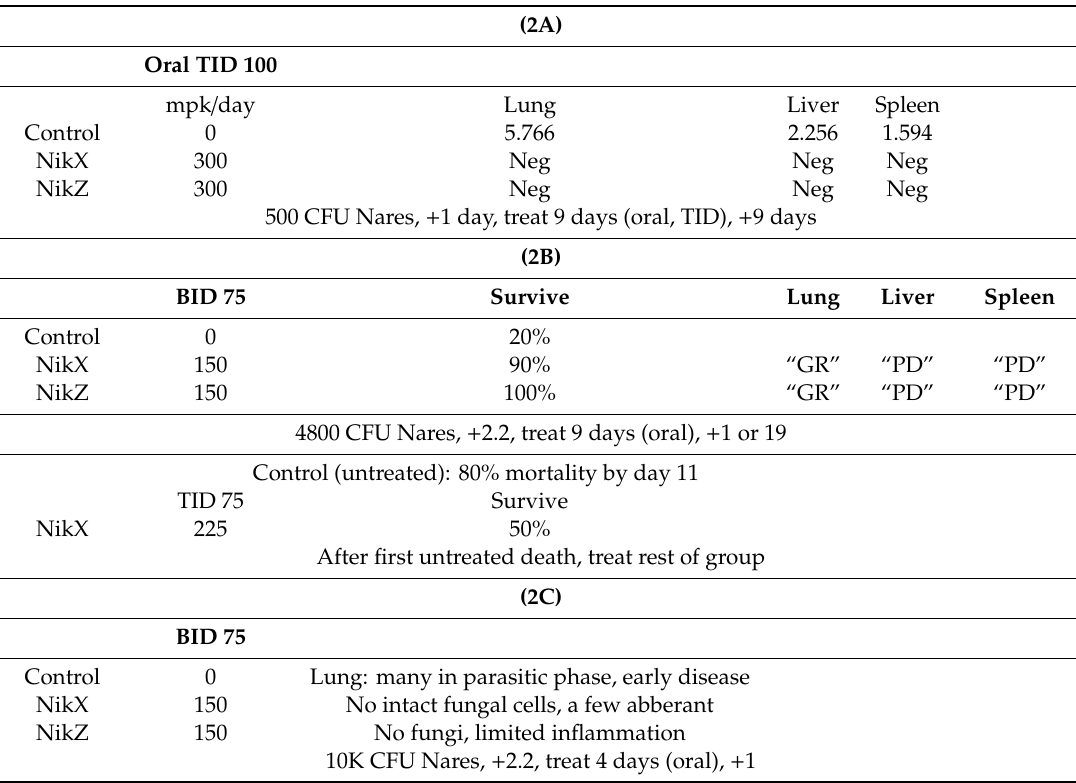
Table 2. Early studies of NikZ (and NikX) against Coccidioides immitis [3]. mpk = mg / kg ( 2A ):